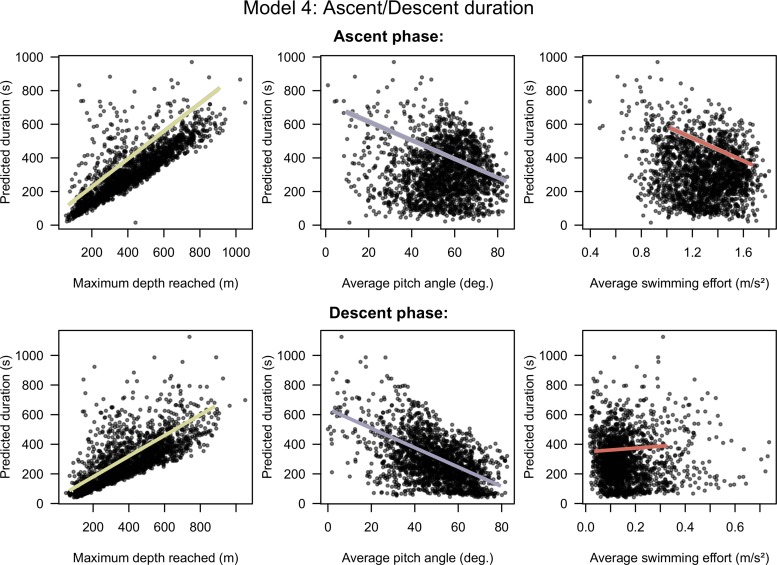
Estimated effects of covariates selected in model 4.The predictions for each covariate varying from the 1% to the 99% quantile of observed values with other covariates at their mean. The x axes have been scaled to range from -3 to 3 normalized so that regression slopes are comparable but are annotated with raw units so that units are comprehensible. The grey shades around the regression lines indicate the standard error of the mean prediction estimates.